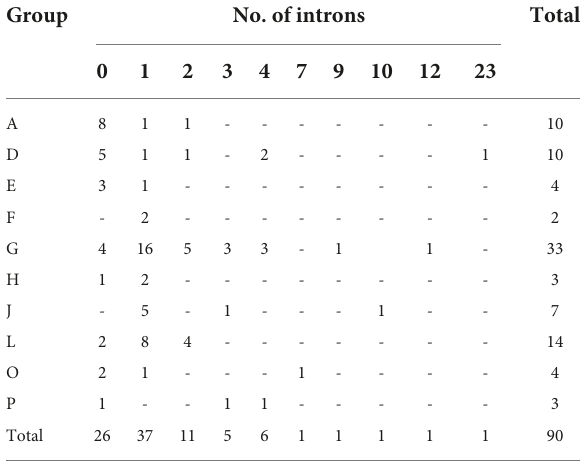
TABLE 1 Number of MsUGT genes in each group according to number of introns. Group No. of introns